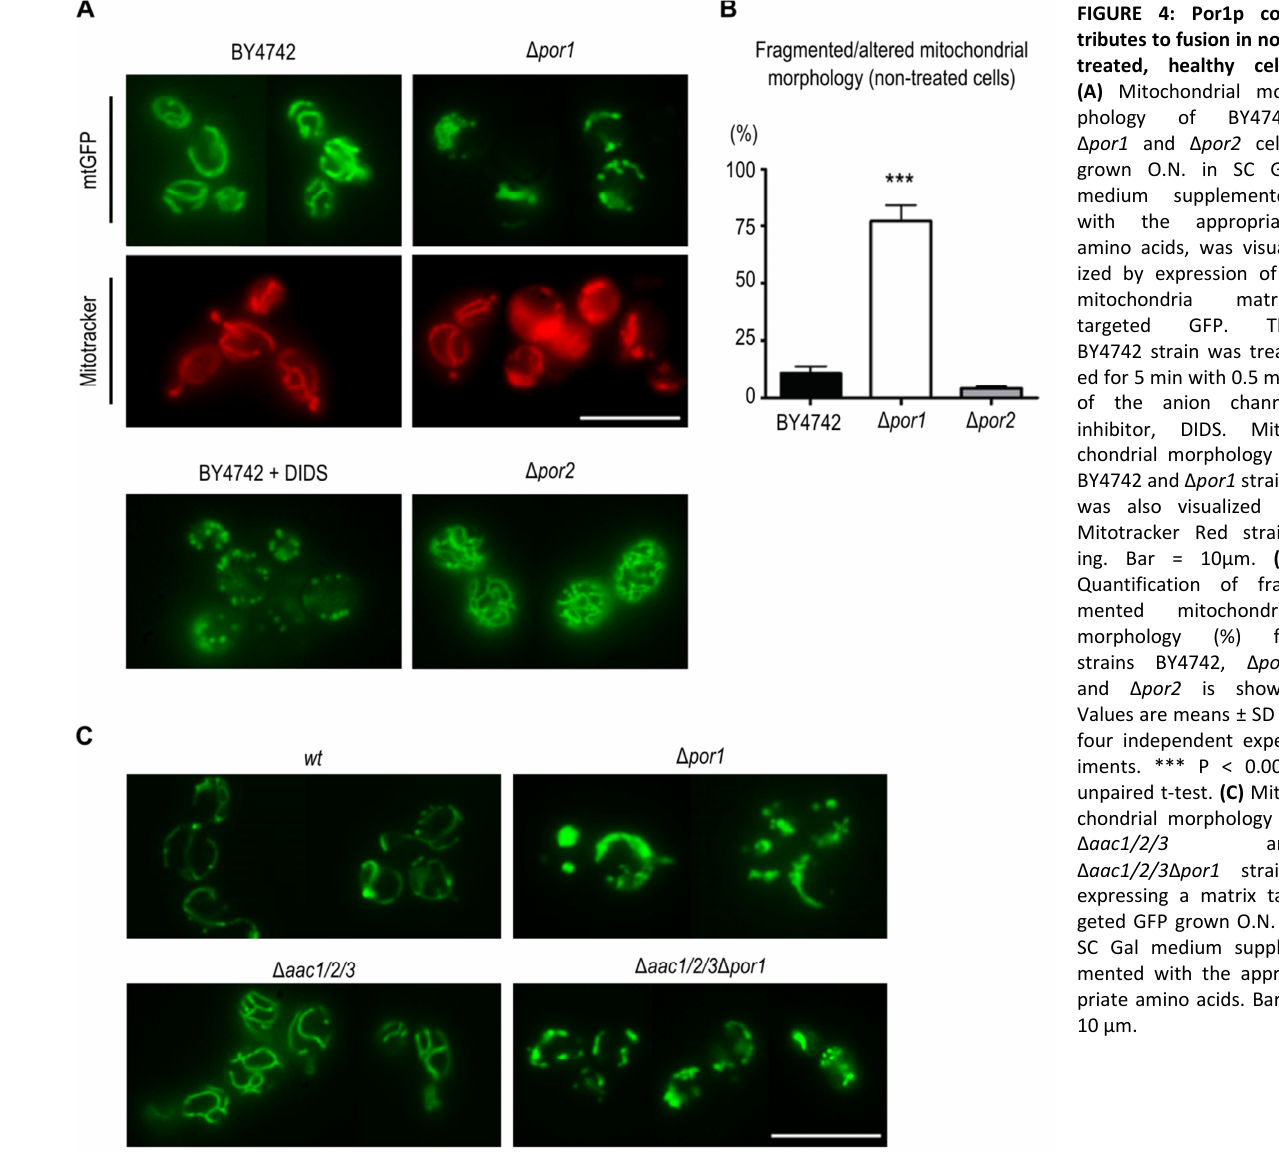
FIGURE 4: Por1p con- tributes to fusion in non- treated, healthy